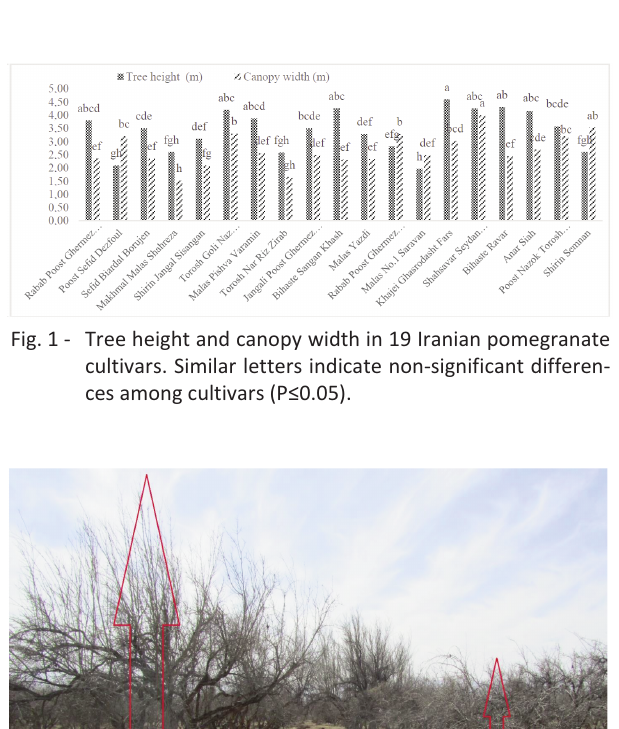
Similar letters in each column indicate non­significant differences among cultivars at